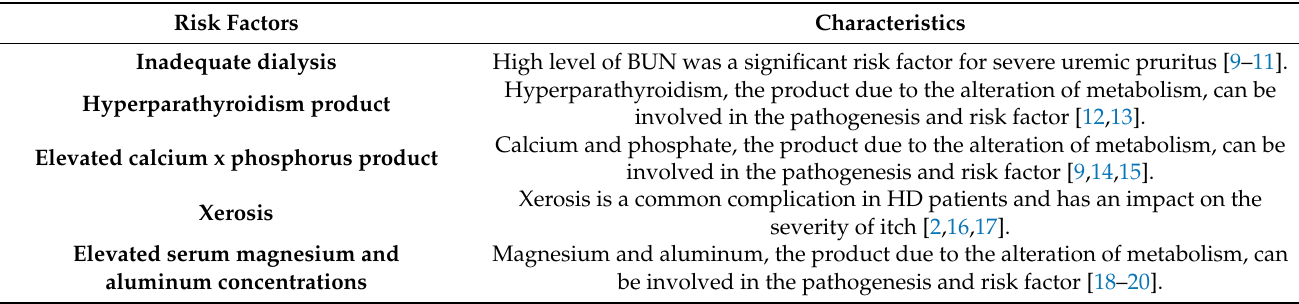
Table 1. Risk factors of patients with CKD associated pruritus.